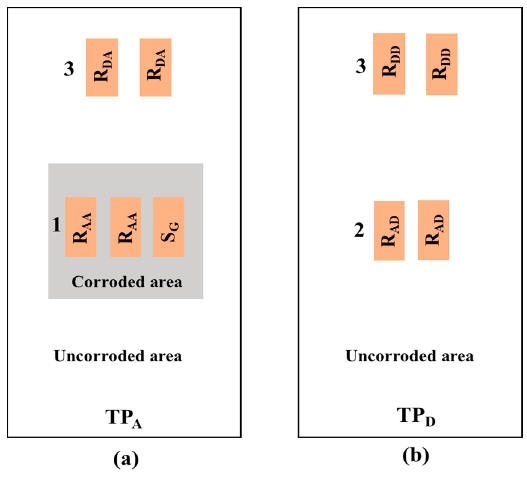
Figure 4. Configuration of strain gauges on test piece for ACM sensor. ( a ) TP A with 900 mm 2 corroded area at the center and the remaining area uncorroded; ( b ) TP D , with the entire test piece uncorroded. Table 1. Position and purpose of strain gauges in Figure 4.